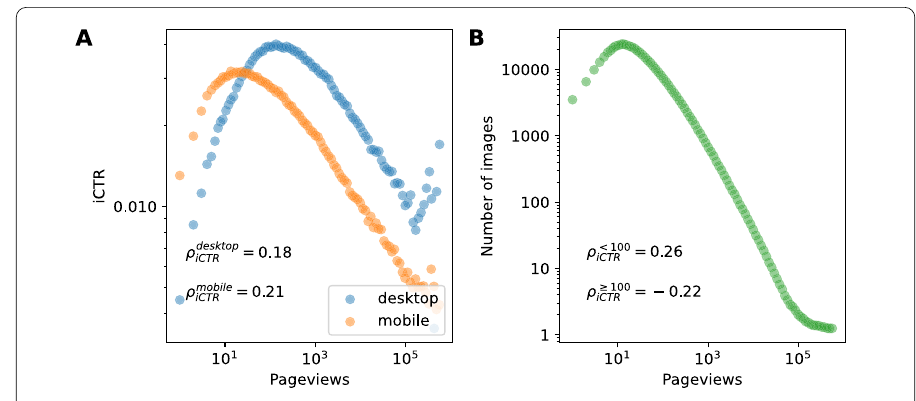
Figure 7 Distributions of ( A ) values of iCTR by page popularity partitioned by device and ( B ) number of images per page popularity. Spearman’s rank correlation coefficient ρ iCTR between iCTR and pageviews in the inset ( p < 0.001). The axes are in log